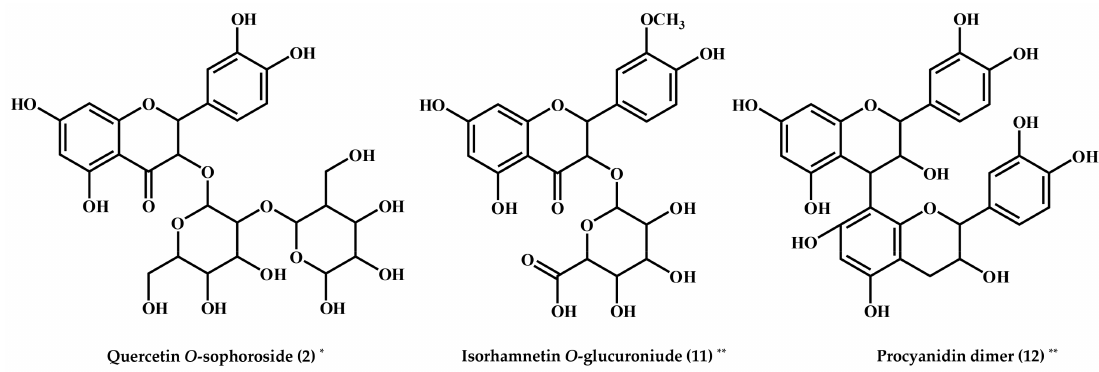
Figure 6. The structures of compounds selected in prep-HPLC fractions from A. aspera and Z. serrata extracts with potent antioxidant activities. * Main antioxidant compound in A. aspera ; ** Main antioxidant compounds in Z. serrata . The number of the fractions, indicated in Table 1, suggest the metabolite